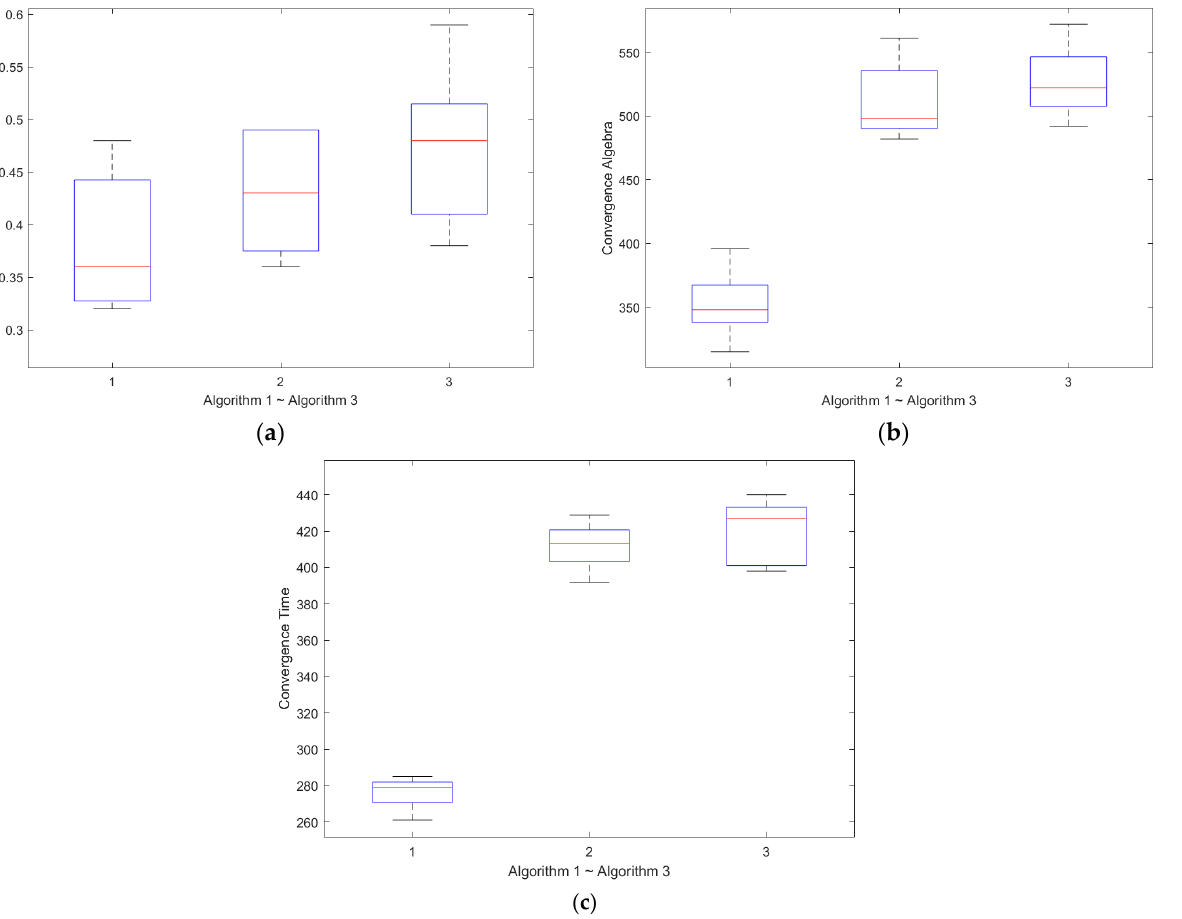
Figure 6. Algorithm performance comparison. ( a ) Comparison of fitness values; ( b ) convergent algebraic comparison; ( c ) convergence time comparison.